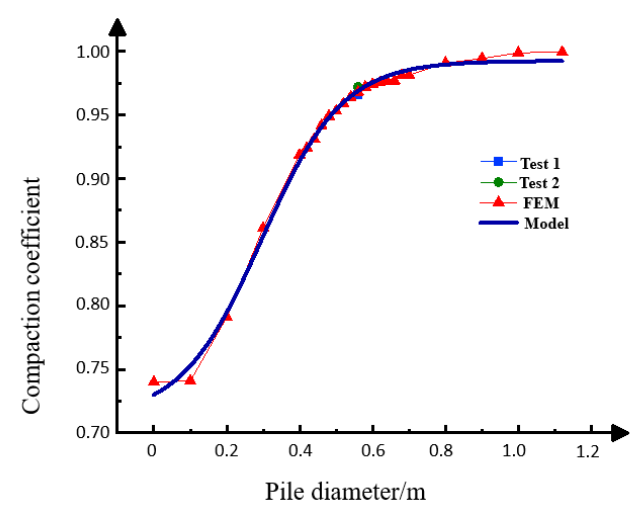
Figure 6. The relationship between the compaction coefficient and D.